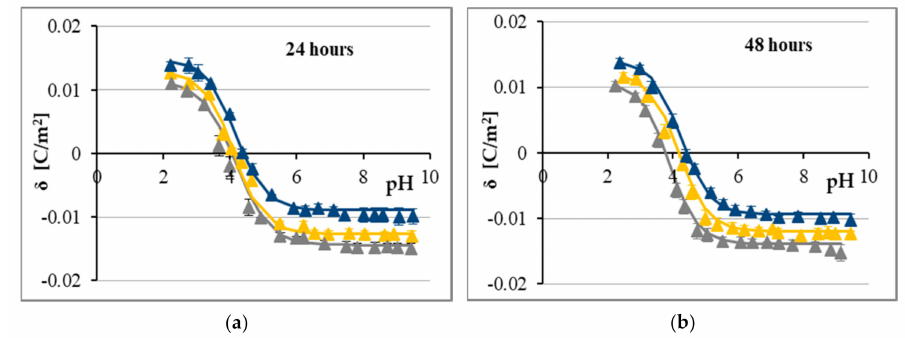
Figure 2. Surface charge density of LN-229 cell membrane versus pH of electrolyte solution. The cells were untreated (grey) or treated with 1.0 (yellow) and 3.5 (navy blue) mmol / dm 3 of CA for 24 h ( a ) and 48 h ( b ). Points denote the experimental values, and the continuous line links the theoretical values.